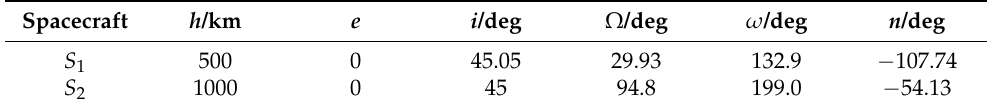
Table 1. Nominal orbit elements of the circle